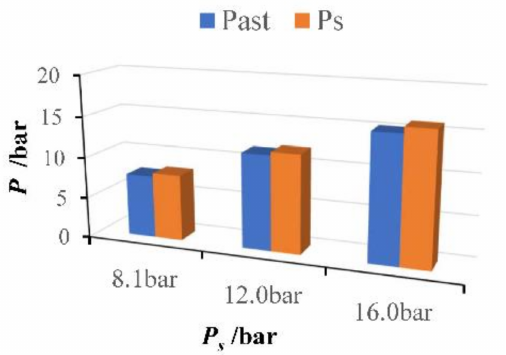
Figure 8. Maximal pilot control pressure at different system pressure levels (experimental data).